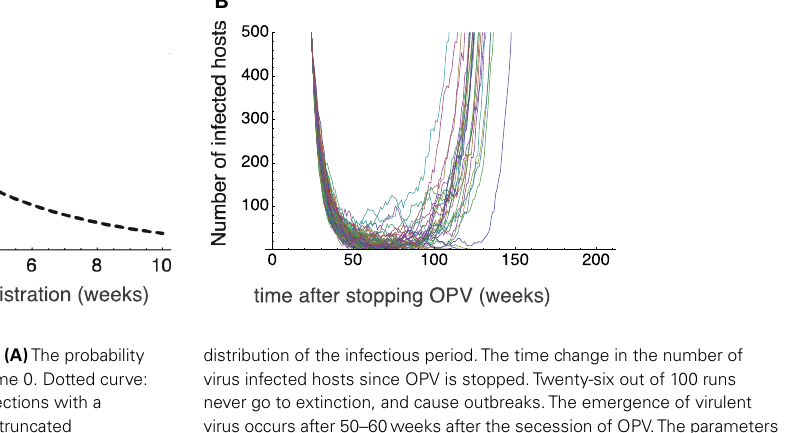
FIGURE 6 |The effect of tail in the infectious period. (A) The probability that the host remains infectious after it is infected at time 0. Dotted curve: the exponential distribution assumed in the previous sections with a constant recovery rate γ = 0.25/week. Solid curve: the truncated distribution in which all the hosts recovers exactly 4weeks after the infection. (B) The Monte Carlo simulation results assuming the truncated